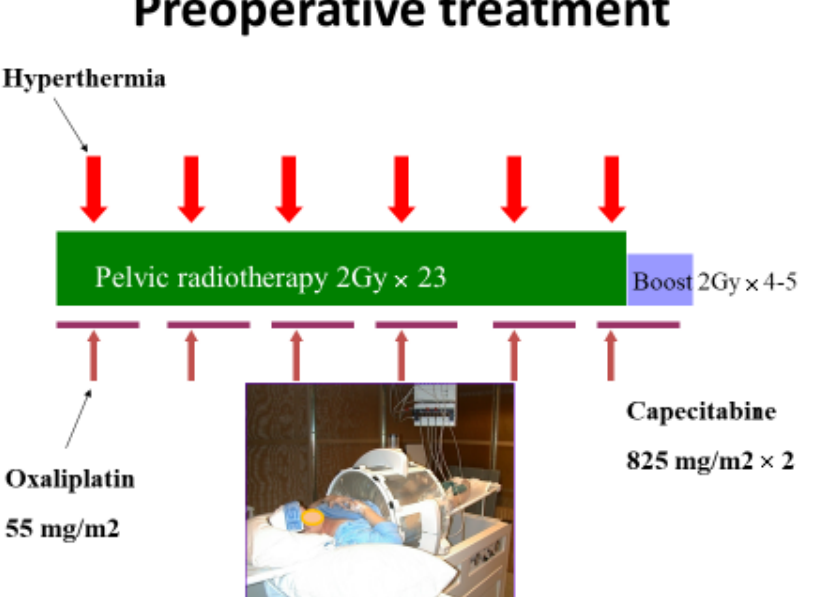
Figure 1. Treatment schedule for preoperative combination treatment by radiation, chemotherapy and hyperthermia for rectal adenocarcinoma.